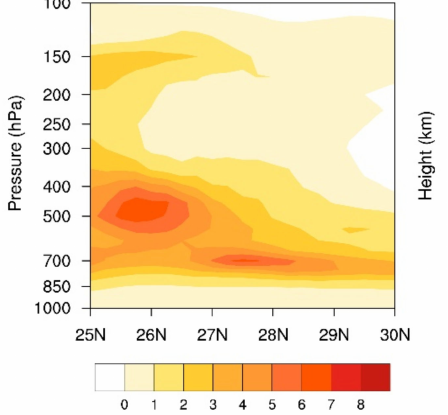
Figure 6. Variation in the abnormal magnification of water vapor transport in the C area with latitude at 05:00 on 16 September (The horizontal axis represents